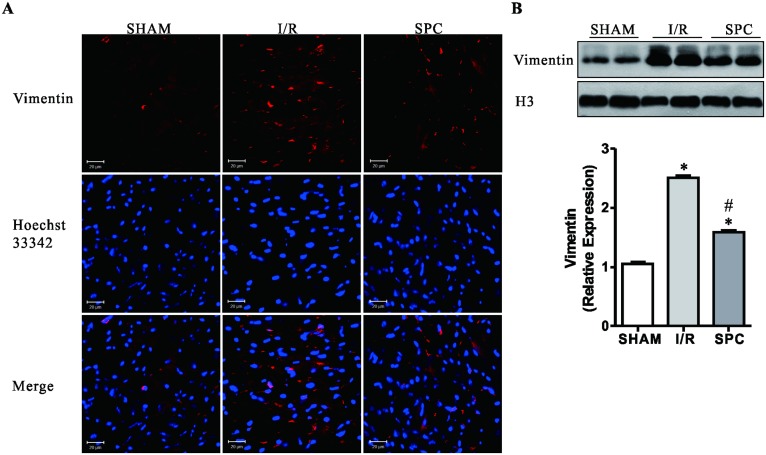
SPC narrows the I/R-induced accumulation of protein aggregates.
(A) Cardiac tissues at papillary muscles level were collected and the cryosectioning was prepared. The immunohistochemical analysis of protein aggregates stained with anti-Vimentin is shown. Hoechst 33342 was used to stain cell nuclei. The immunofluorescence was examined by a confocal microscope. Scale bar: 20μm. n = 3 /group (B) Representative immunoblots of nuclear protein from all groups detected with a Vimentin-specific antibody. H3 was utilized to normalize the amount of protein. n = 4 /group. The columns and errors bars represent means ± SD. * P < 0.05 vs. SHAM group; # P < 0.05 vs. I/R group.